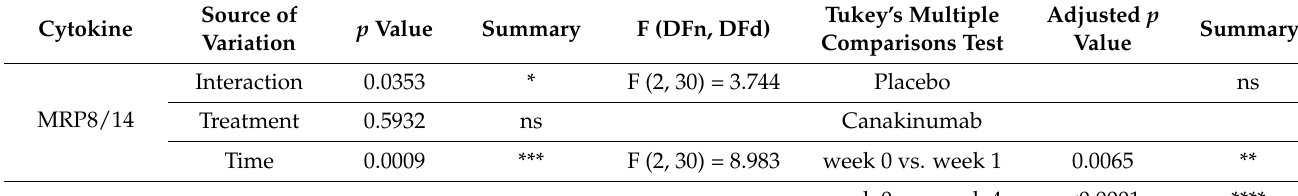
Table 2. Detailed results of two-way repeated-measures ANOVA with Tukey’s and Sidak’s multiple comparisons tests for placebo and canakinumab groups. * p < 0.05, ** p < 0.01, *** p < 0.001 and **** p <